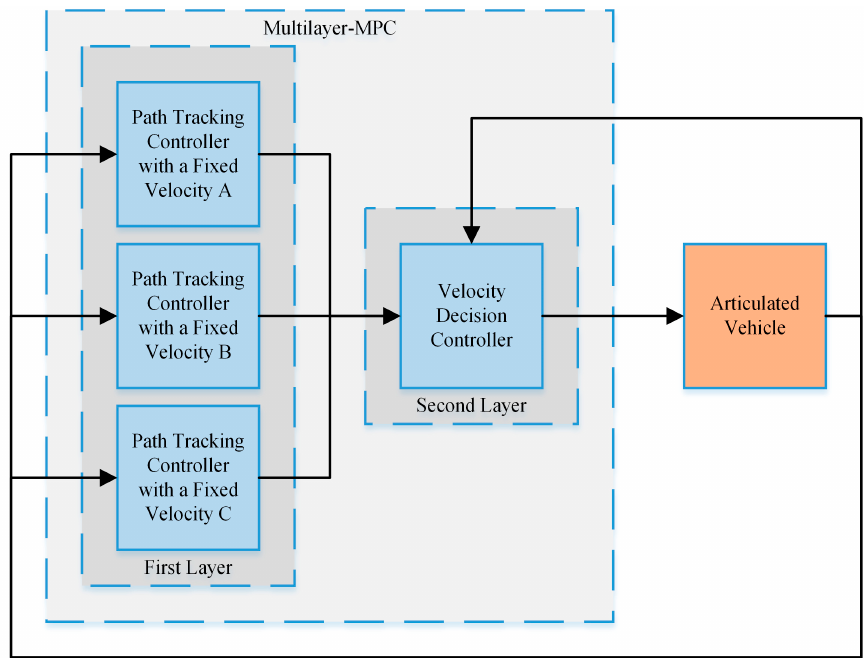
Figure 1. The framework of multilayer model predictive control (MPC).